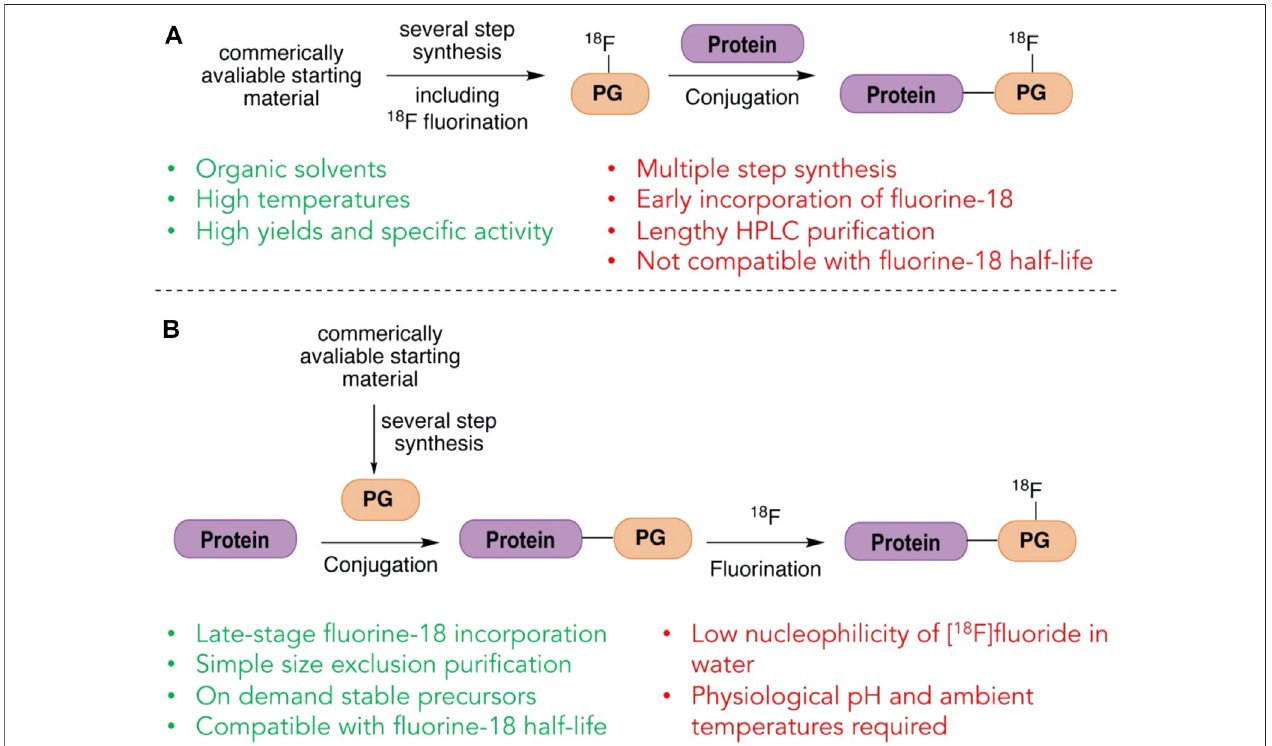
FIGURE 1 | Indirect and direct strategies for labeling with fl uorine-18. (A) In indirect labeling of proteins with fl uorine-18, aprosthetic group (PG) is fi rst labeled with fl uorine-18 and puri fi ed before ligating to the protein. (B) In direct labeling of proteins with fl uorine-18, the prosthetic group (PG) is attached fi rst and the fl uorine-18 labeling is done in the fi nal